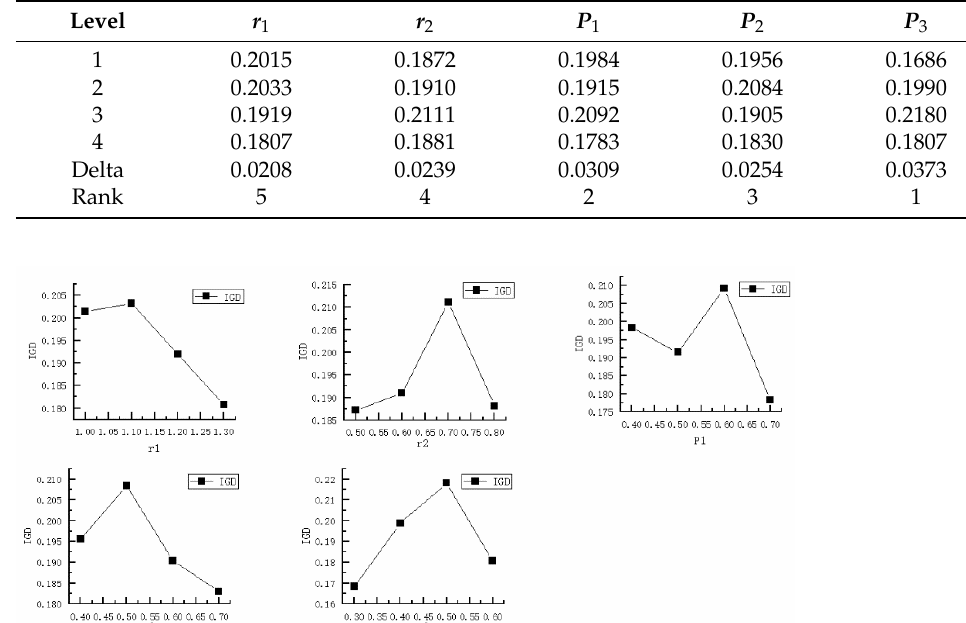
Table 4. Response values and rank of parameters.